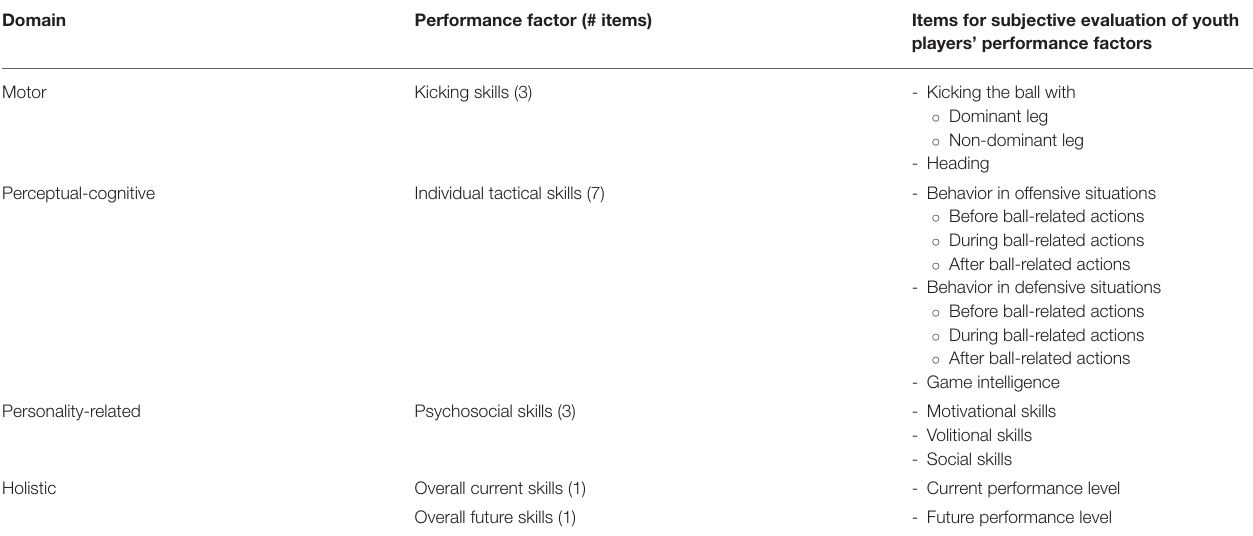
TABLE 1 | Subjectively assessed youth players’ performance factors (modified from Höner et al., in